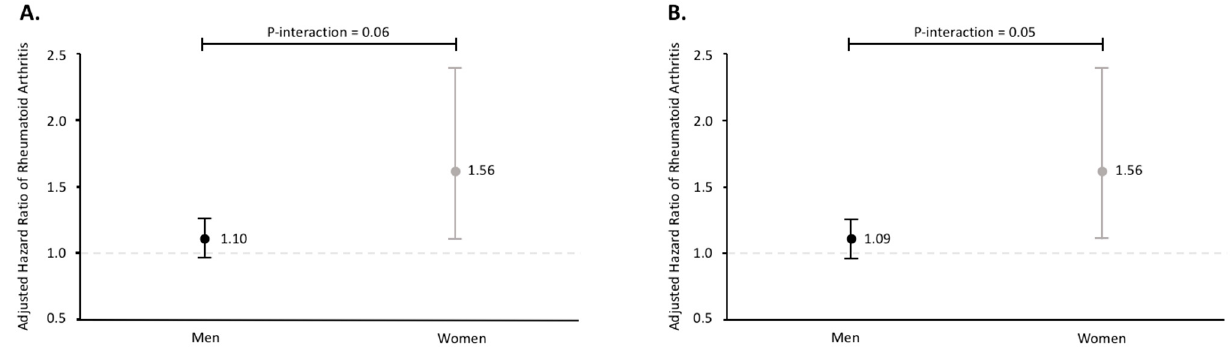
Figure 1. Sex-specific hazard ratio of rheumatoid arthritis for each 10 g increase in alcohol consumption in all participants ( A ) and excluding past drinkers ( B ), adjusting for age, body mass index (<18.5, 18.5–23, 23–27.5, and >27.5 kg/m 2 ), and smoking (never, past, and current).